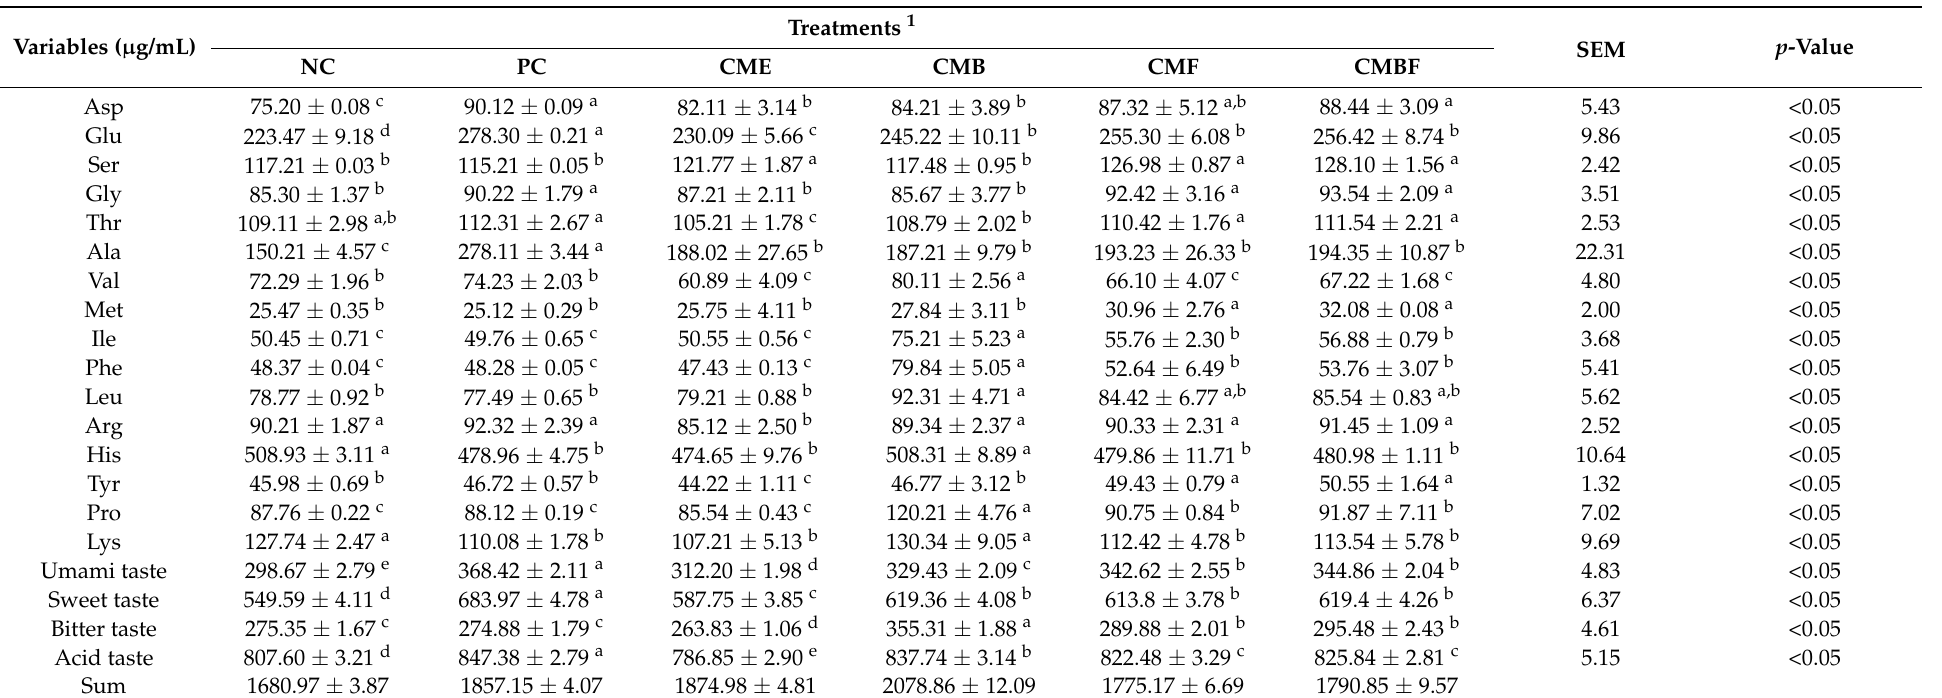
Table 6. Free amino acid profiles of the breast meat of Korean ginseng chicken soup that was hydrolyzed with Cordyceps militaris mushroom